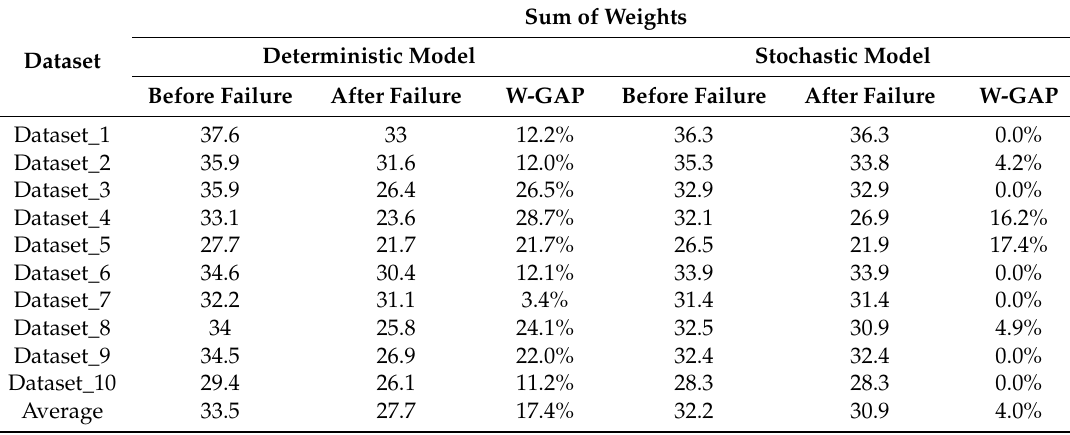
Table 3. Comparison of the sum of weights when there is a deterioration in the patient’s